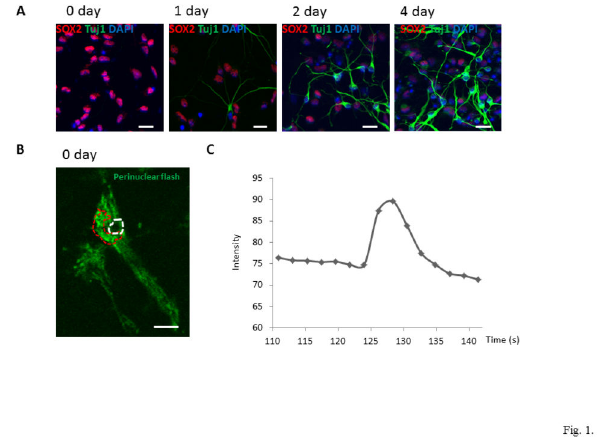
Figure 1. Characterization of mitochondrial SO flashes in NPCs. (A) Cell differentiation was induced by growth factor removal. NPCs and neurons were identified by antibodies against Sox2 (red) and Tuj1 (green), respectively, at different days of differentiation. The nuclei of NPCs were counterstained with DAPI (blue). Bar = 20 µm. (B-C) Characteristics of typical mitochondrial SO flashes in NPCs (day 0). The area circumscribed with the red dashed line is a perinuclear region where SO flashes occurred, and the area circumscribed with the white dashed line is the nucleus. Bar = 5µm (B). Change of mt-cpYFP fluorescence intensity during time course of a typical SO flash